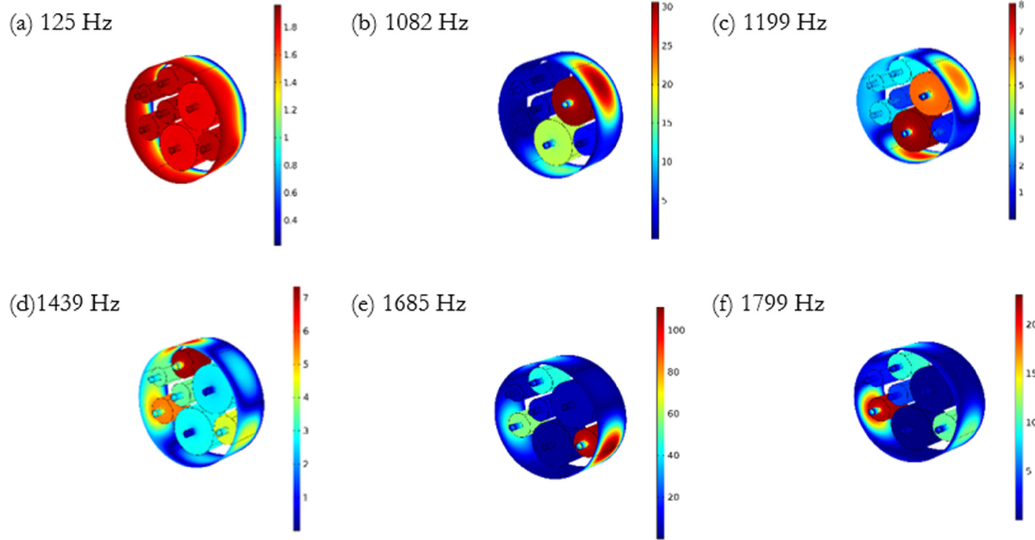
Figure 8. Sound interaction of metamaterial plate when frequency approaches the resonance fre- quency of the resonators .